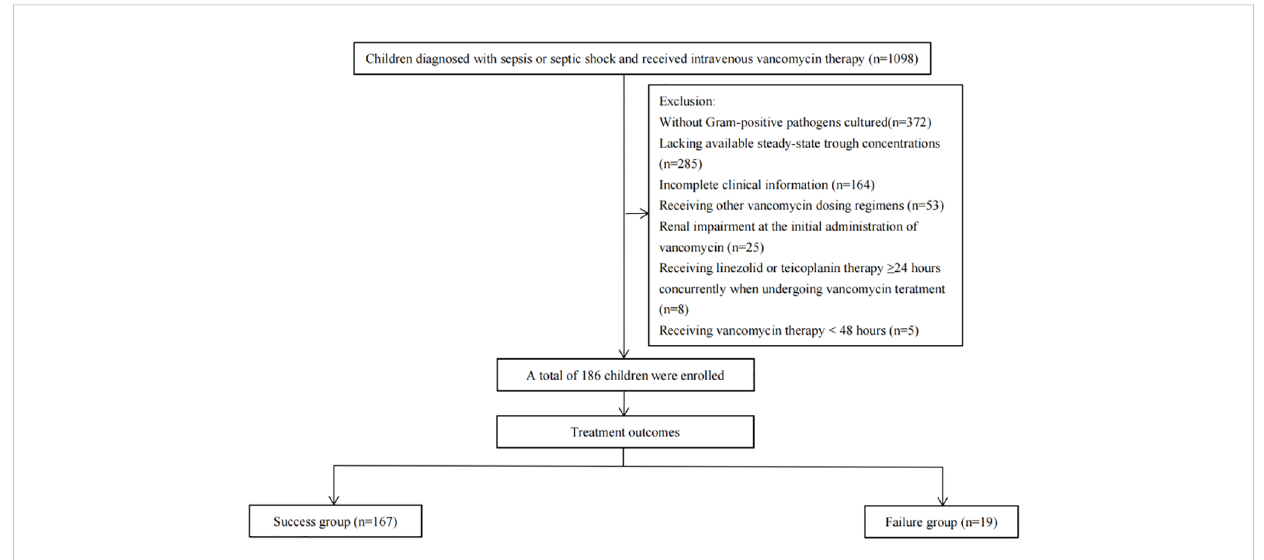
FIGURE 1 Flow chart of patients